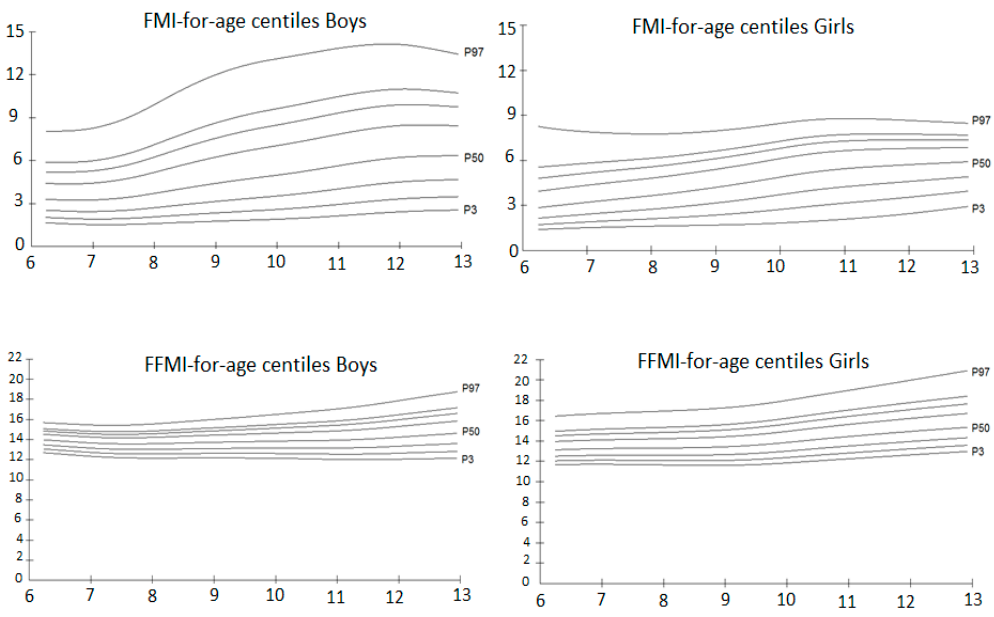
Figure 2. Percentile curves of the 3rd (P3), 10th, 25th, 50th (P50), 75th, 85th, 90th, and 97th (P97) for fat mass index (FMI) and fat free mass index (FFMI) by age and gender.